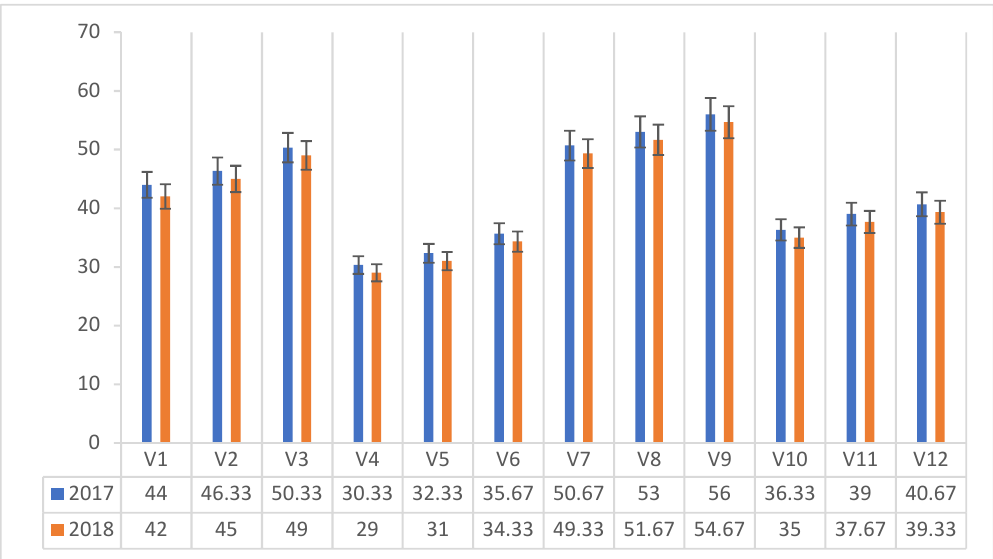
Figure 7. PP vitamin content of Agaricus blazei Murrill mushrooms (mg 100g −1 dm) in two years of experimental trial.